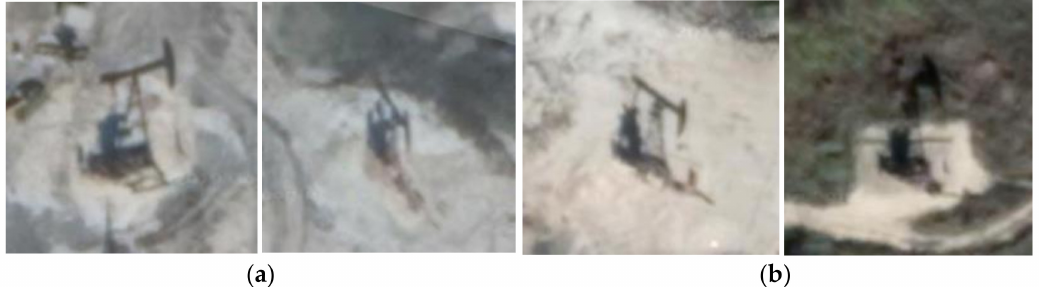
Figure 3. The challenges in the detection of oil wells from remote sensing images. ( a ) Oil wells angle differences in remote sensing images. ( b ) Oil wells background differences in remote sensing